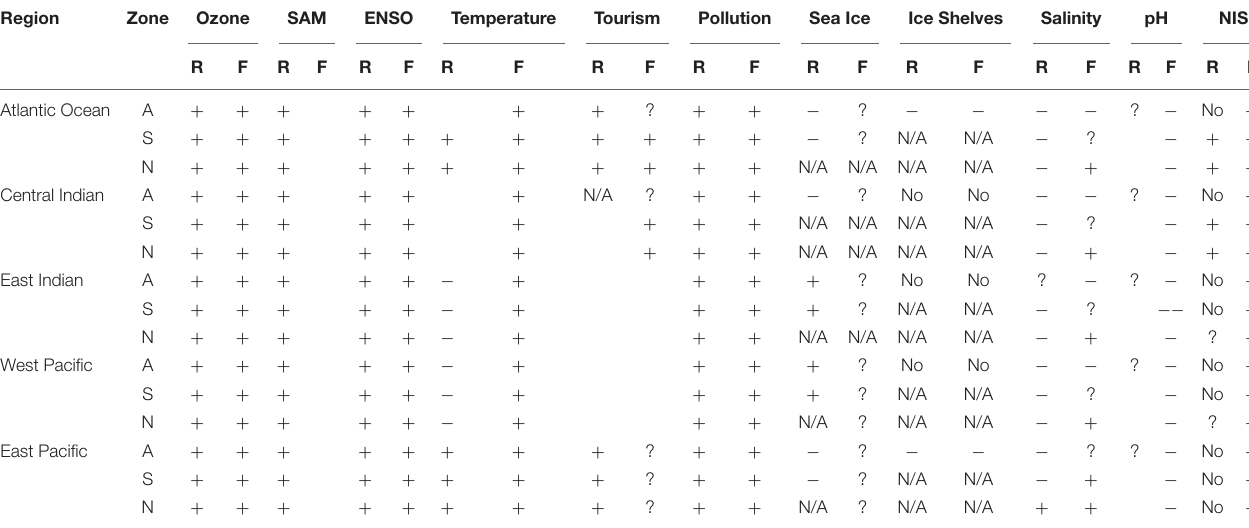
TABLE 1 | Assessment of the current direction of each of the identified global drivers within the MEASO sectors, in recent times (R) and in the future (F). Region Zone Tourism